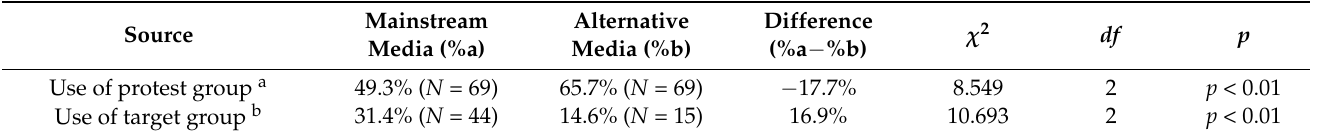
Table 4. Comparison of sources cited between mainstream media and alternative